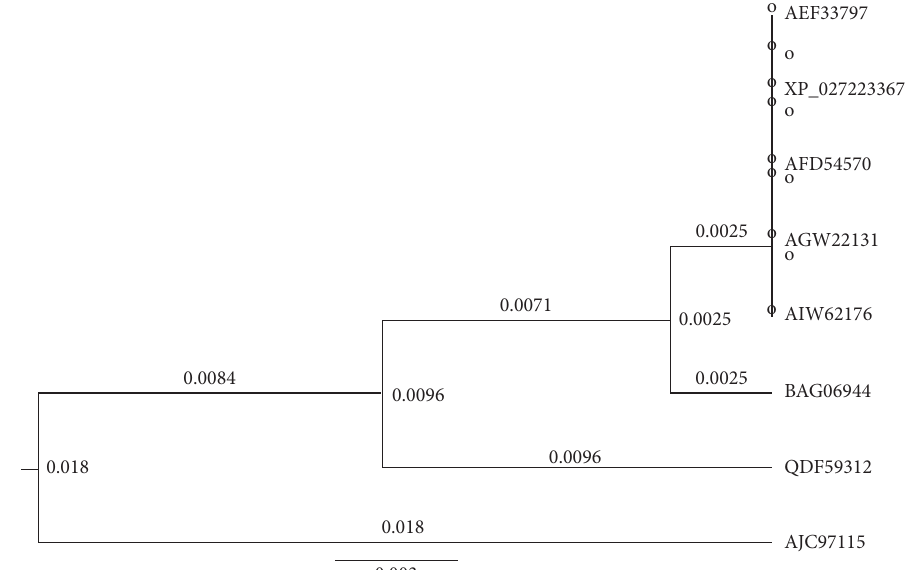
Figure 3: Phylogenetic tree showing evolutionary relationships of WSSV receptor protein Rab7 in Penaeus monodon with other closely related